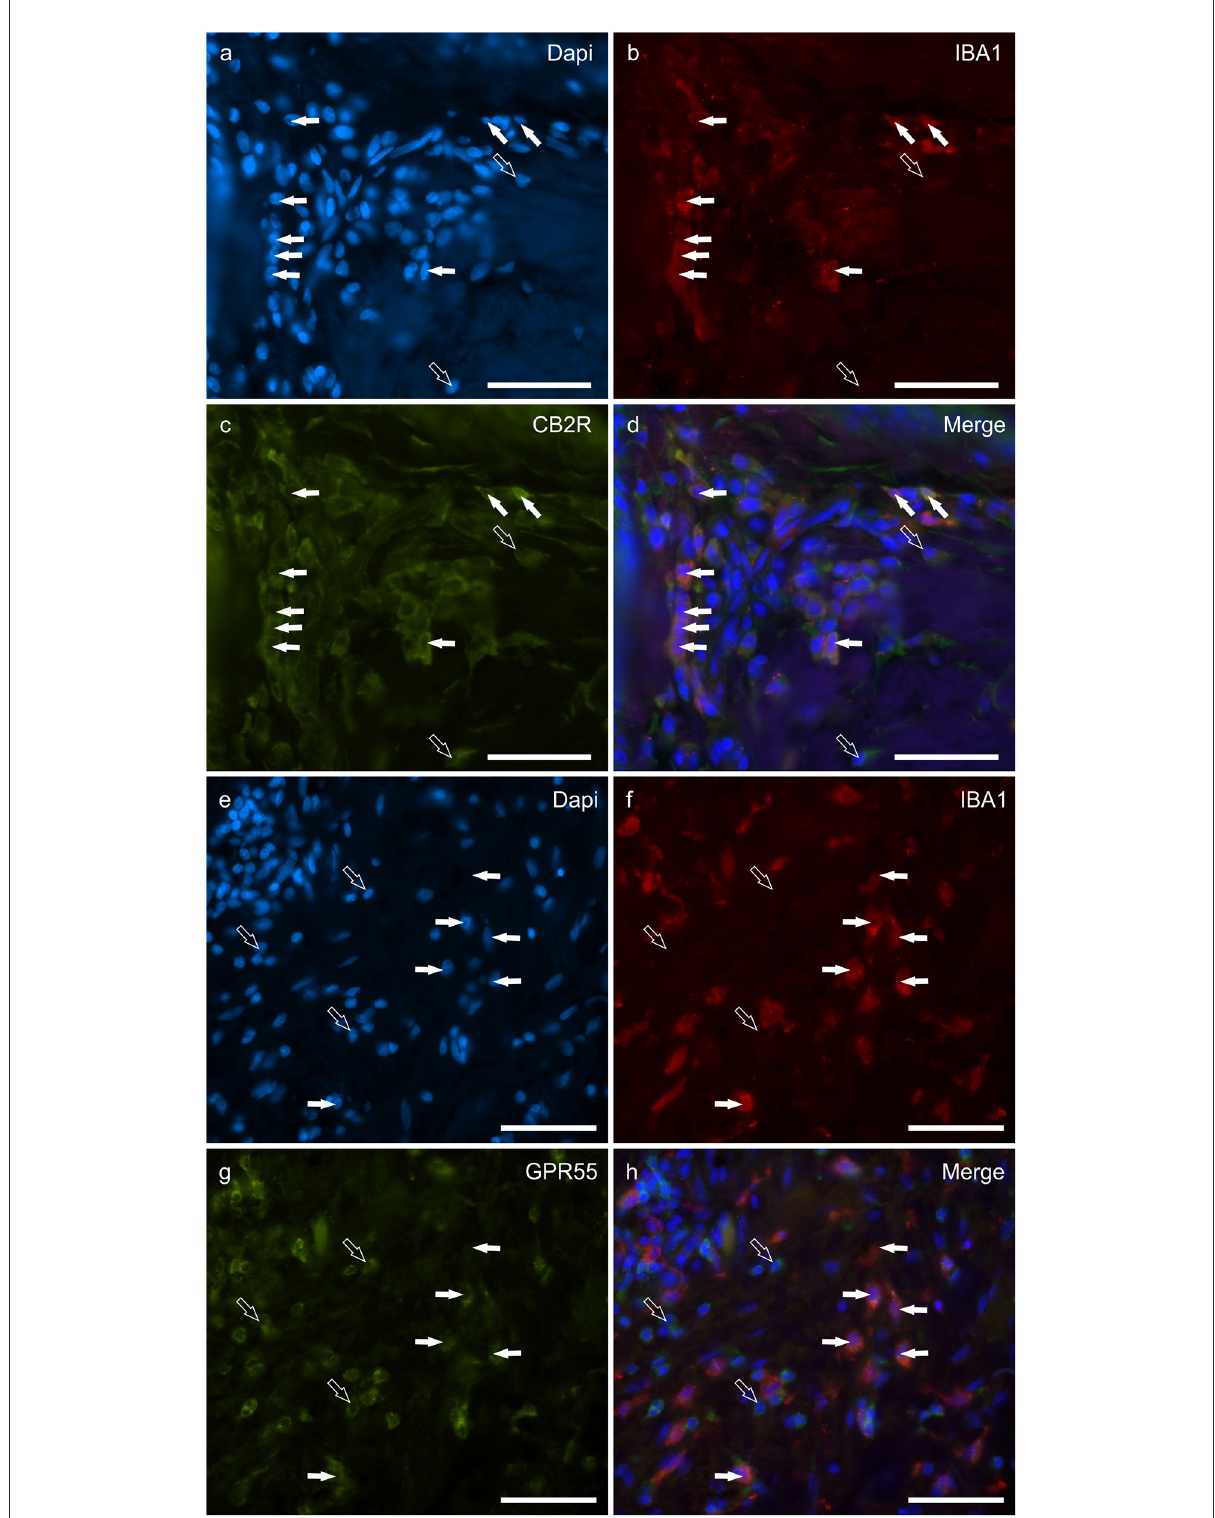
FIGURE3 Photomicrographs of the cryosections of the skin of dogs with atopic dermatitis (AD) showing IBA1 immunoreactive cells (macrophages and dendritic cells) expressing cannabinoid receptor 2 (CB2R) (a–d) and G-protein coupled receptor 55 (GPR55) (e–h) immunoreactivity (IR). The white arrows indicate the Dapi-labeled nuclei of IBA1 positive cells co-expressing CB2R- (c) and GPR55-IR (g) . The open arrows indicate some IBA1 negative cells of the dermis which expressed CB2R- (c) and GPR55-IR (g) . Bar: 50 µ